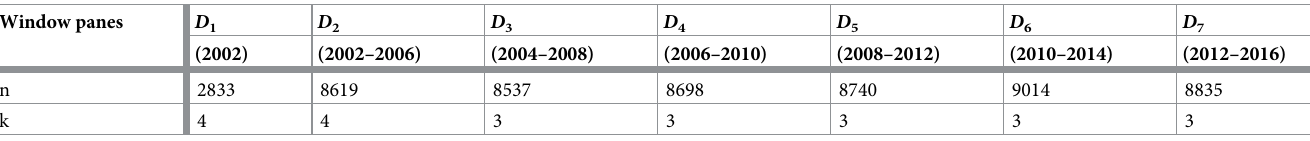
The implementation of the sliding window model generates 7 panes of cumulative datasets. The second row shows the cumulative number of participants in respective surveys. Whereas the third row represents the optimal number of clusters in each window pane. The optimal number of clusters is calculated using the silhouette